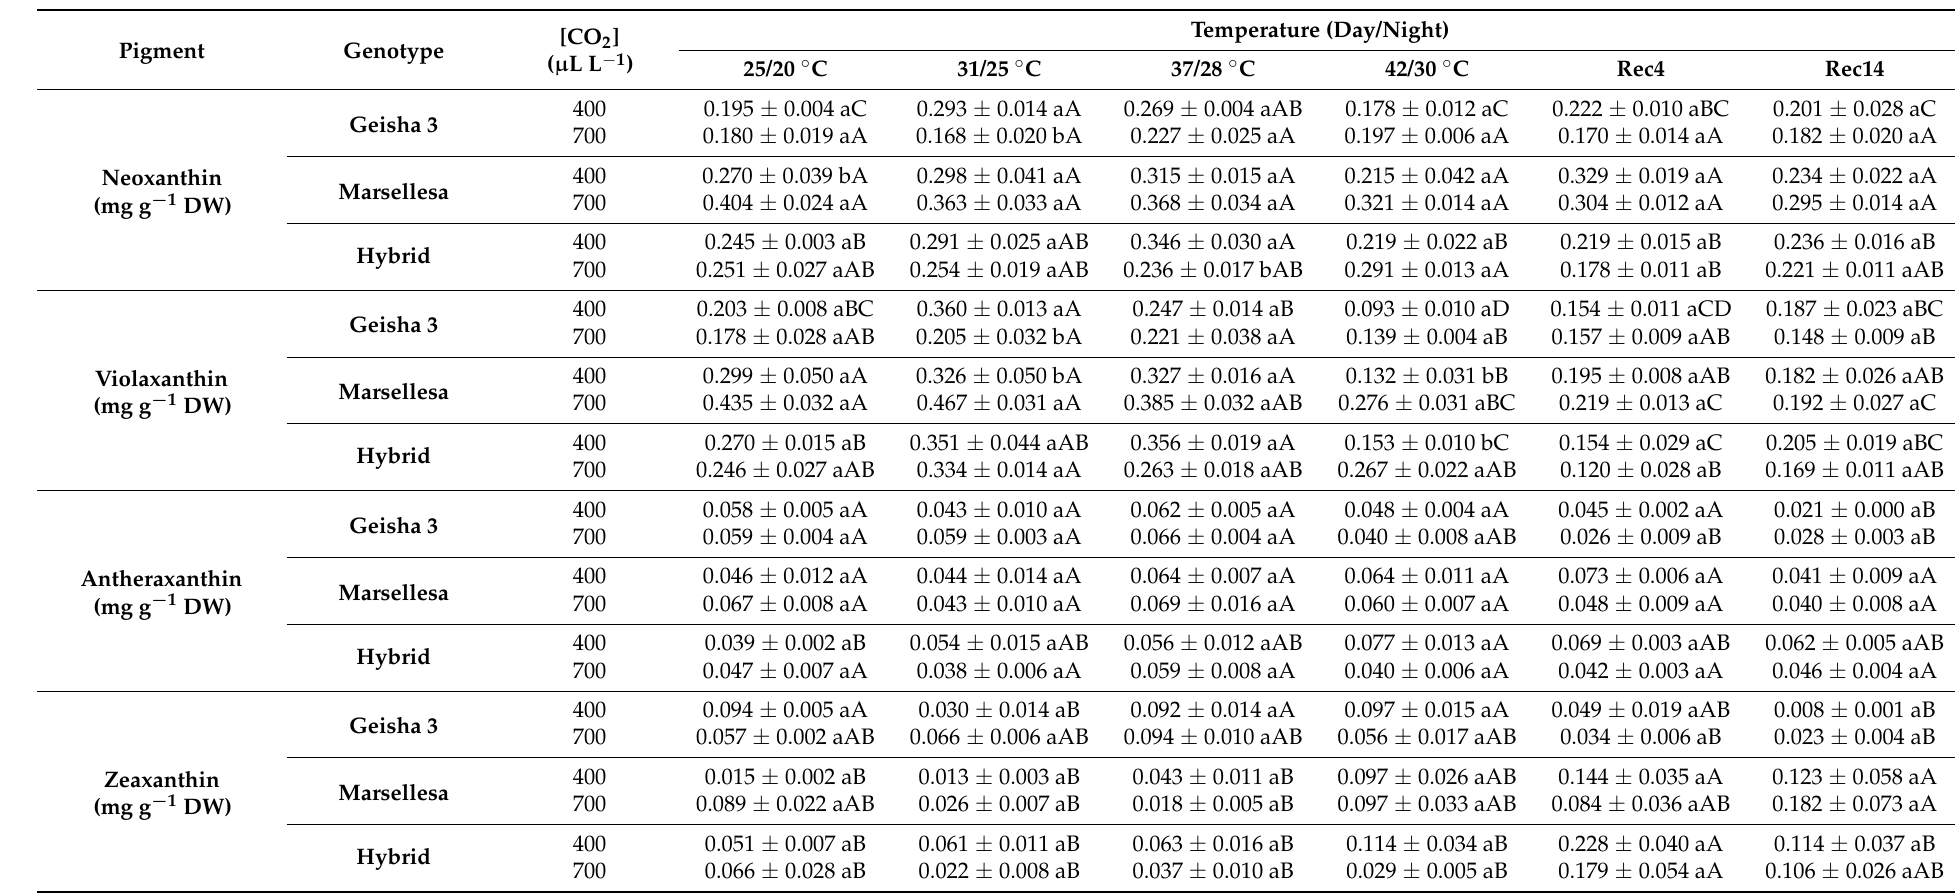
Table 1. Leaf carotenoids concentration (mg g − 1 dry weight, DW) in C. arabica cv. Geisha 3, cv. Marsellesa and their Hybrid (Geisha 3 × Marsellesa) plants